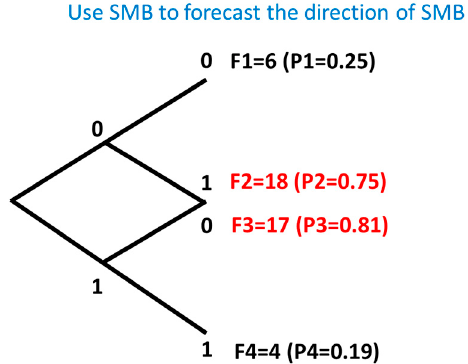
Figure A9. Use SMB to forecast the direction of SMB.